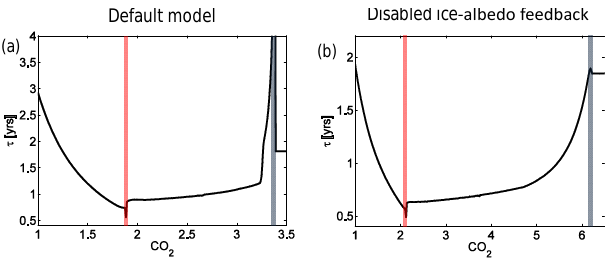
Figure 3. Relaxation timescale in Eisenman’s (2007) box model for (a) the original model and (b) with disabled ice–albedo feedback. The vertical shaded lines indicate the values of CO 2 where the an- nual minimum (red) and maximum (blue) ice volume reaches